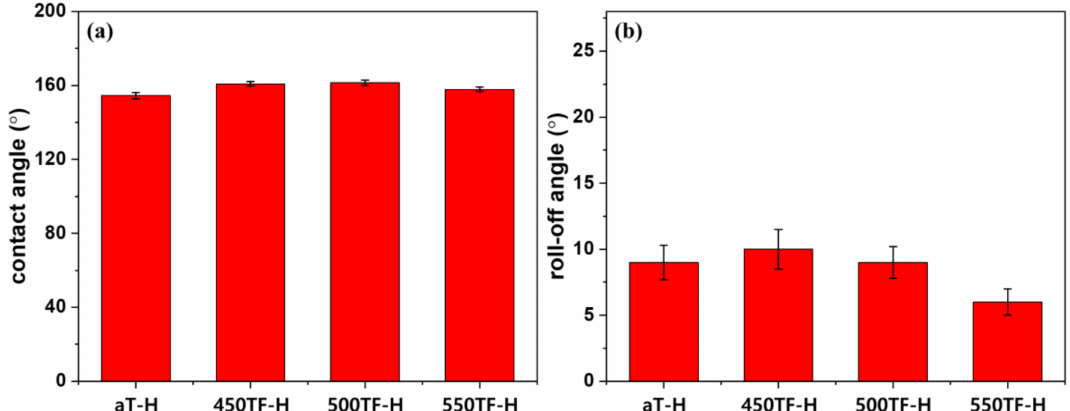
Figure 9. Superhydrophobic self-cleaning properties of the photocatalyst/HDS-treated PET fabrics; ( a ) contact angle and ( b ) roll-off angle.